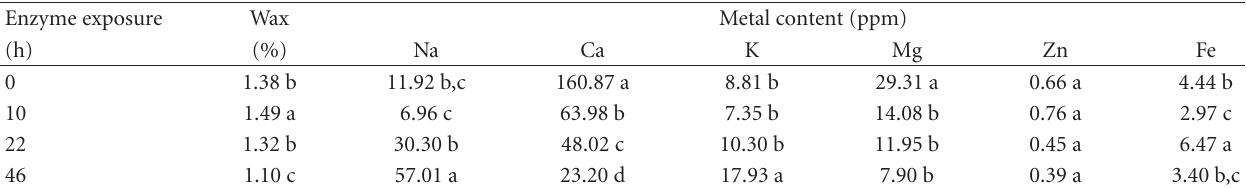
Table 3: Chemical properties of enzyme-retted flax fibers ∗ .